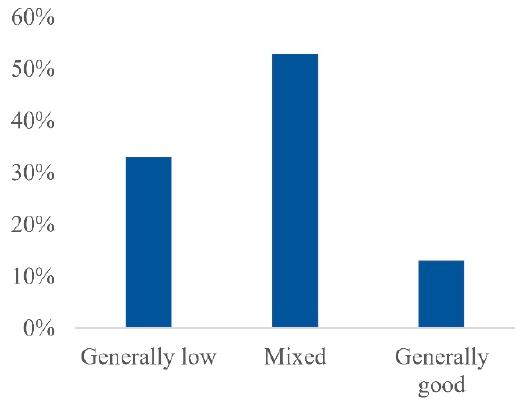
Figure 2. Industry 4.0 awareness level in Kazakhstan companies.